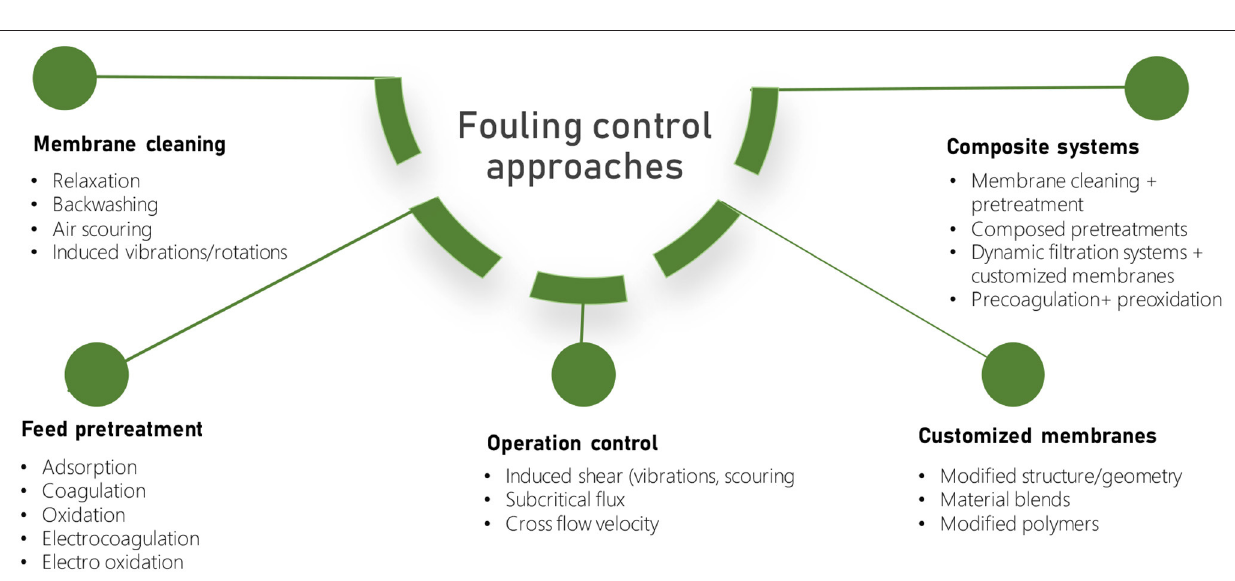
FIGURE 5 | Summary of fouling control approaches in algal membrane separation